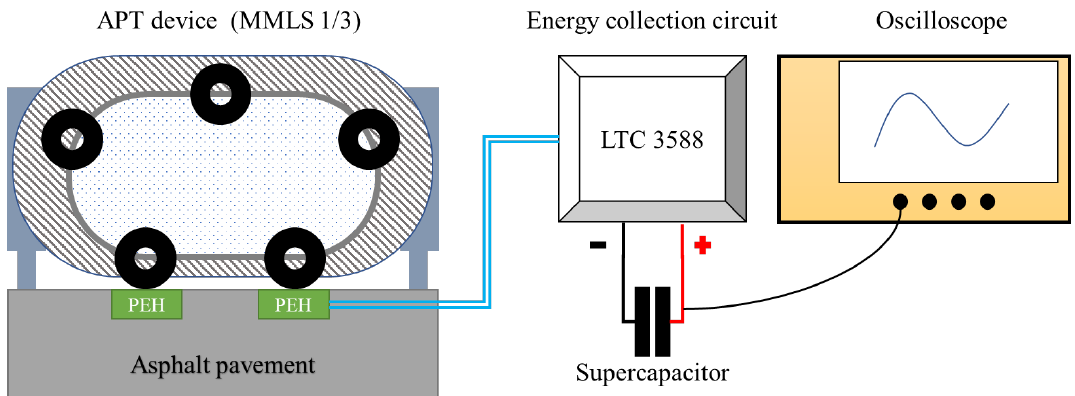
Figure 6. Diagram of the laboratory pavement loading test.